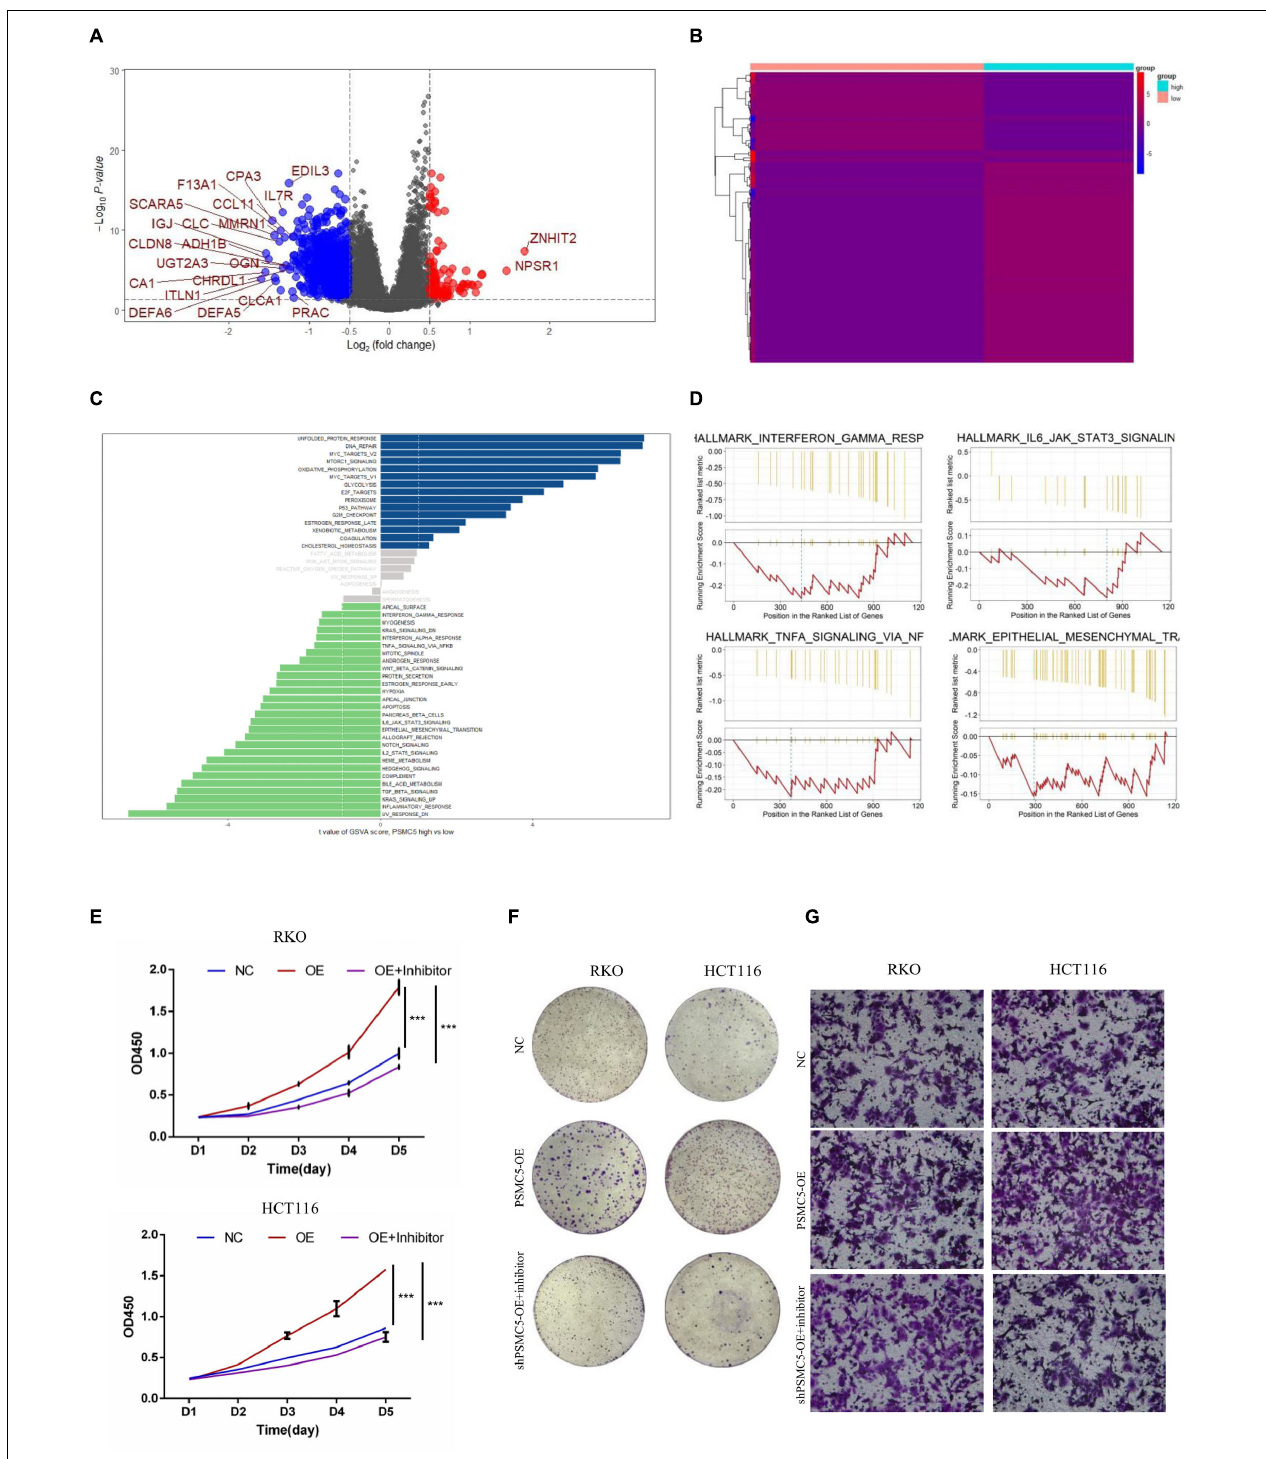
FIGURE 4 | PSMC5 promoted proliferation and invasion of CRC cells by activating epithelial–mesenchymal transition. (A,B) Differentially expressed genes (DEGs) showed by volcano plot (A) or heatmap (B) . DEGs with log2FC > 1 are shown in the volcano plot. (C,D) PSMC5-related pathways were analyzed with Gene Set Variation Analysis (GSVA; C ) and Gene Set Enrichment Analysis (GSEA; D ) algorithm. (E,F) MTT assay (E) and colony formation assay (F) showing that the enhanced cell growth induced by PSMC5 could be dampened by EMT inhibitor. Difference across groups was determined by one-way ANOVA test. *** p < 0.001. (G) Transwell assay examined the invasive ability of three groups of CRC cells (control, PSMC5-OE, and PSMC-OE + EMT inhibitor). CRC, colorectal cancer; EMT, epithelial–mesenchymal transition.